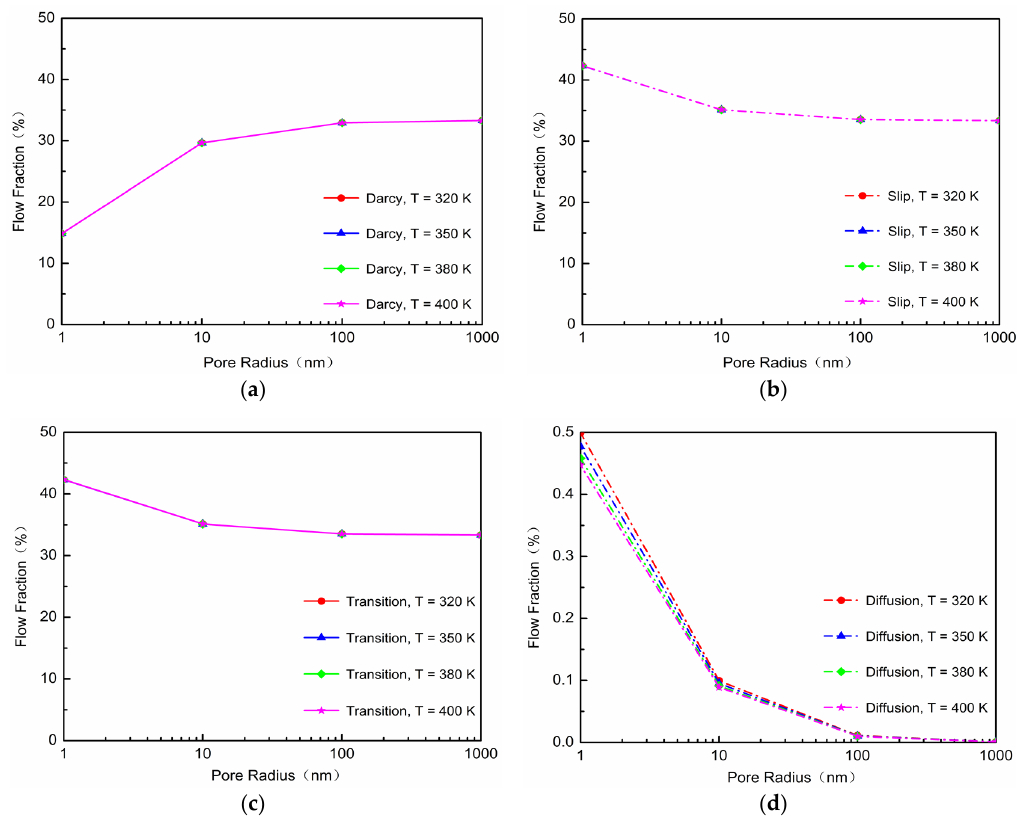
Figure 4. Gas flow fraction versus pore radius for various temperatures. ( a ) The fraction of Darcy flow; ( b ) the fraction of Slip flow; ( c ) the fraction of Transition flow; and ( d ) the fraction of Diffusion flow.